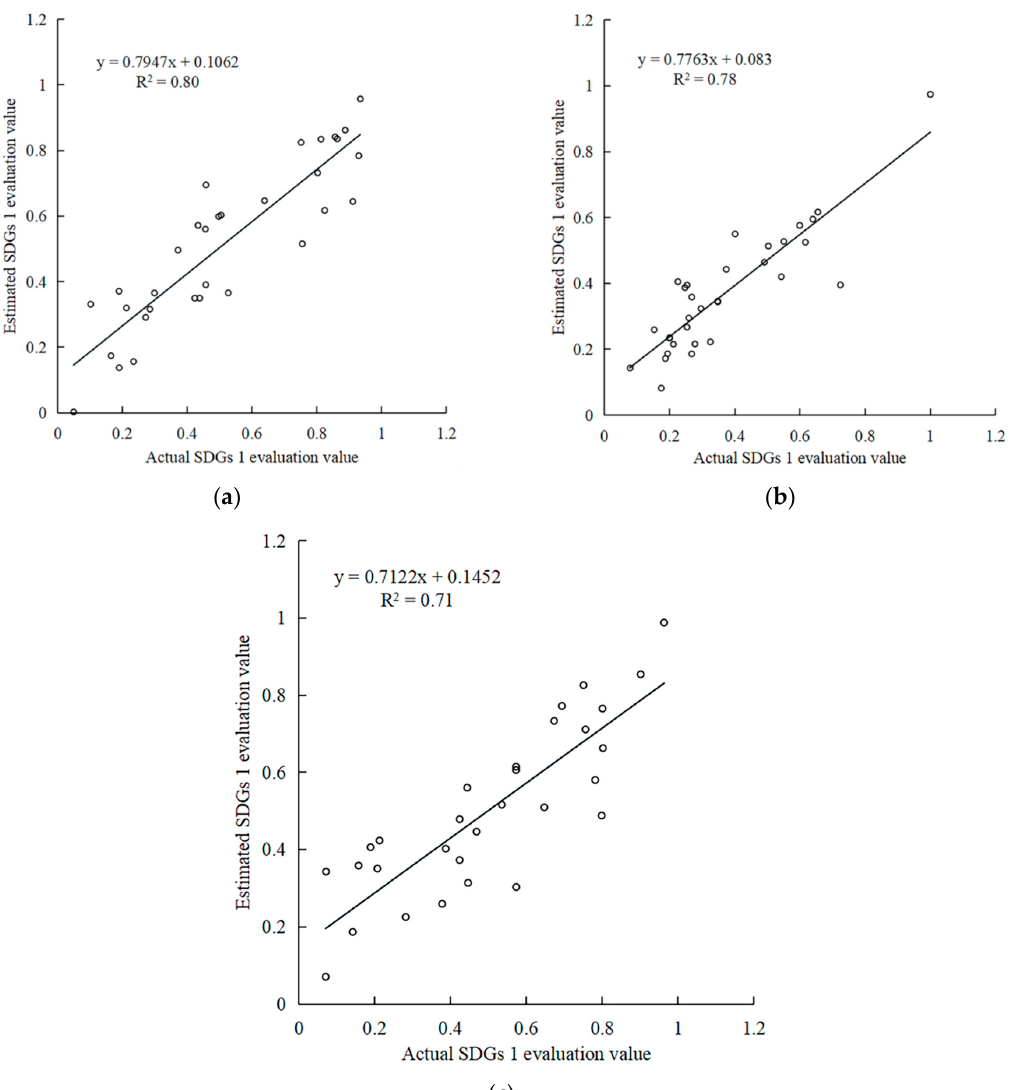
Figure 9. ( a – c ) are the scatter plots of the estimated and actual SDG 1 evaluation values in Hunan Province in 2014, 2016 and 2018, respectively.